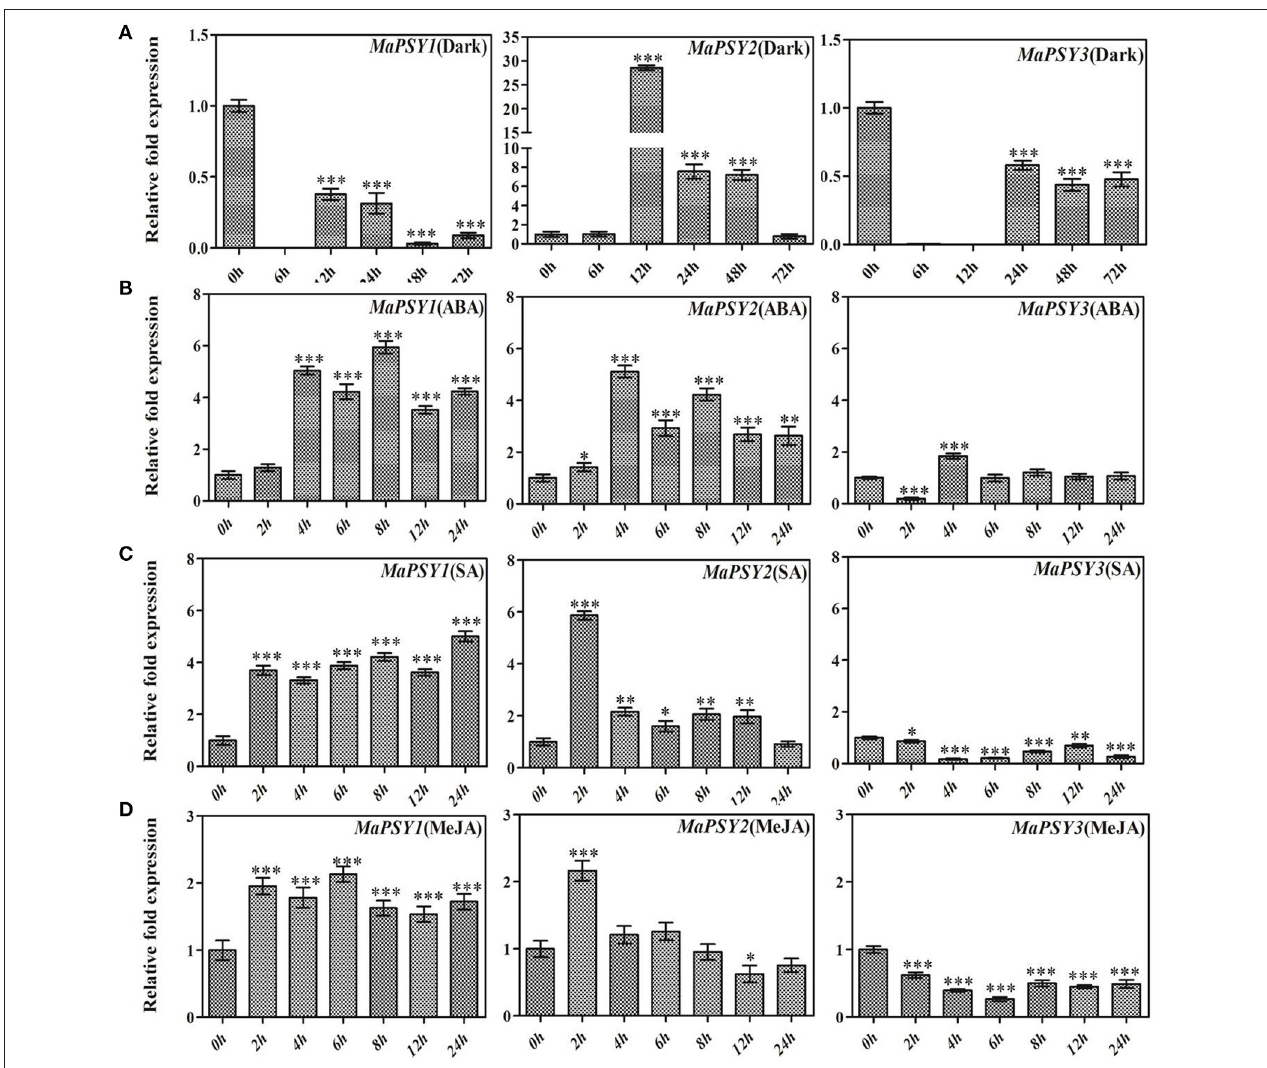
FIGURE 4 | Real-time PCR expression analysis of PSY genes under stress conditions. Transcript expression profiles are presented in in-vitro grown Rasthali plants under (A) dark, (B) methyl jasmonate, (C) abscisic acid, and (D) salicylic acid exposures. The gene expression was normalized with reference to actin1 taken as internal control. Bars denote mean fold expression as compared to the control (0 h sample). Statistical analysis was performed using Student’s paired t -test. Statistical significance was checked at P ≤ 0.05–0.001 (* P ≤ 0.05; ** P ≤ 0.001; *** P ≤ 0.0001) with respect to the 0 h